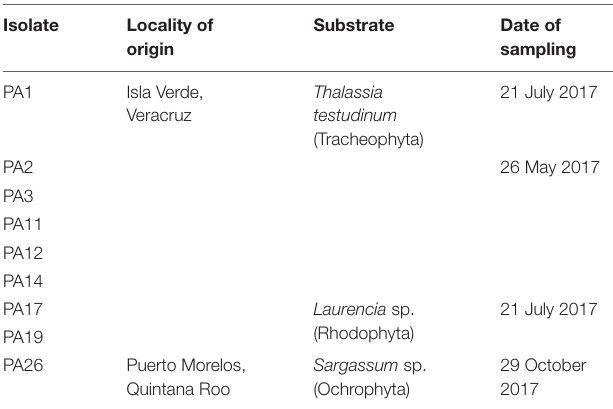
TABLE 1 | Geographical origin of the monoclonal isolates of the Prorocentrum lima species complex (PLSC) obtained for this